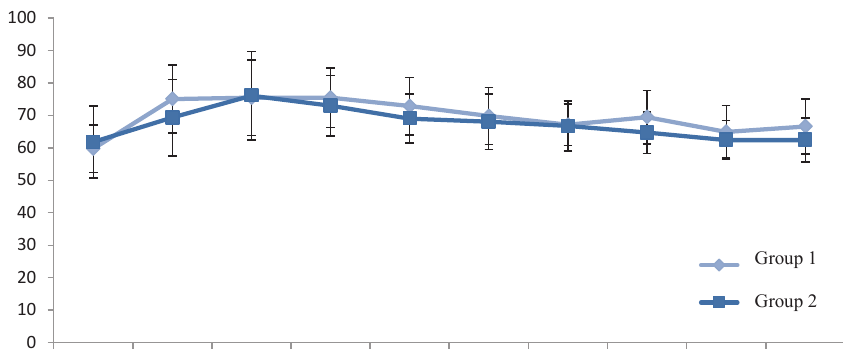
Figure 2. The blood pressure of patients during the study in groups 1 (ropivacaine) and 2 (lidocaine with epinephrine).